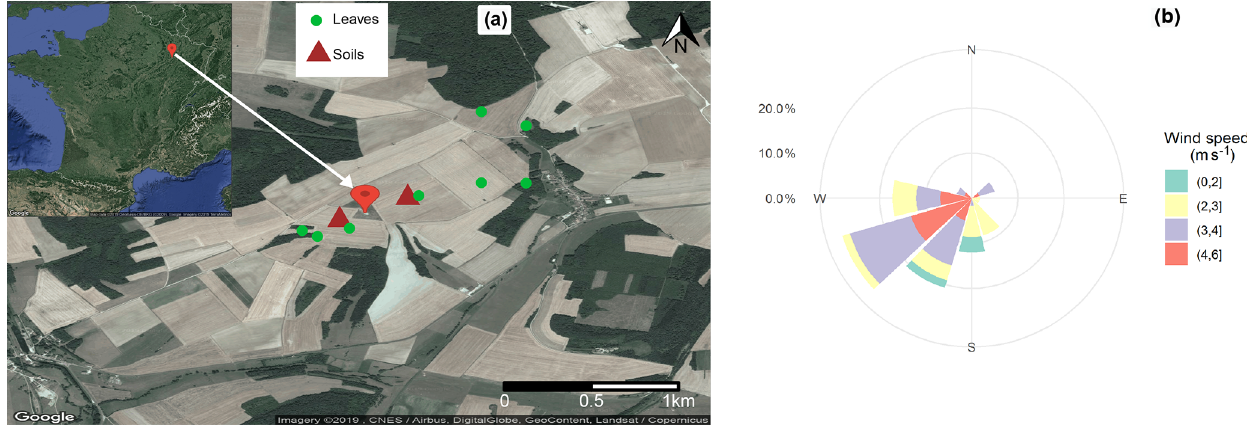
Figure 1. Overview of the sampling area at the OPE site (France). (a) Location of sampling units and (b) wind conditions (speed and direction) during the field-sampling campaign